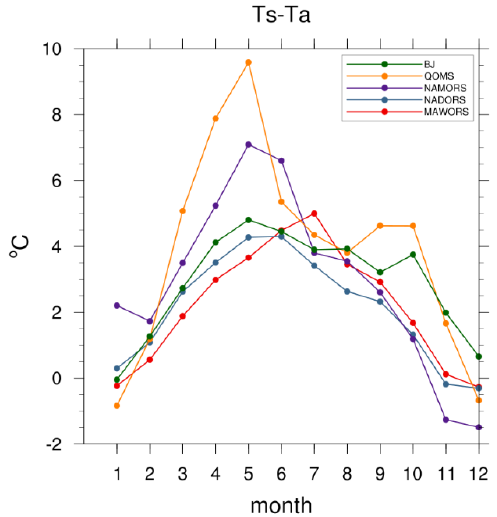
Figure 25. Annual variation of the difference between surface temperature and surface air temperature at each station.